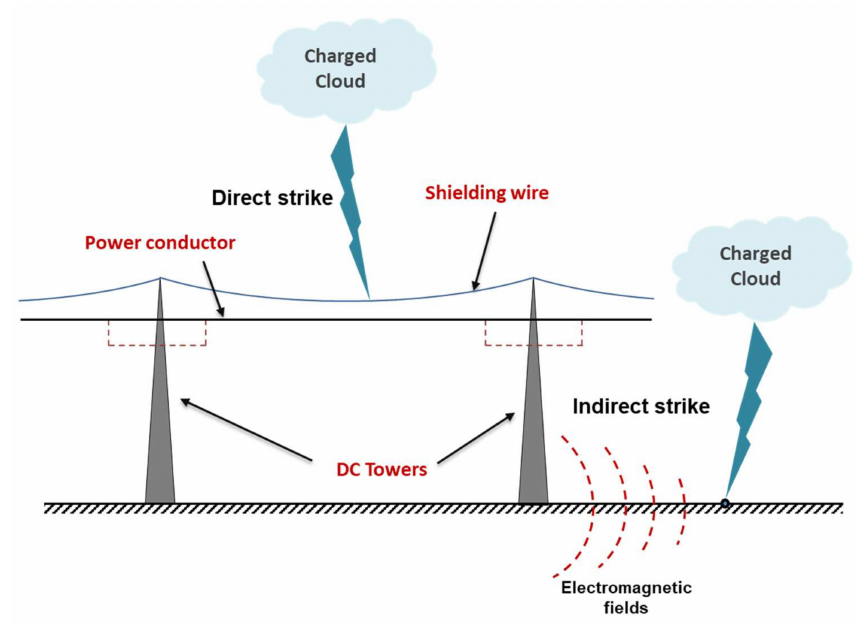
Figure 1. Schematic diagram of lightning strike